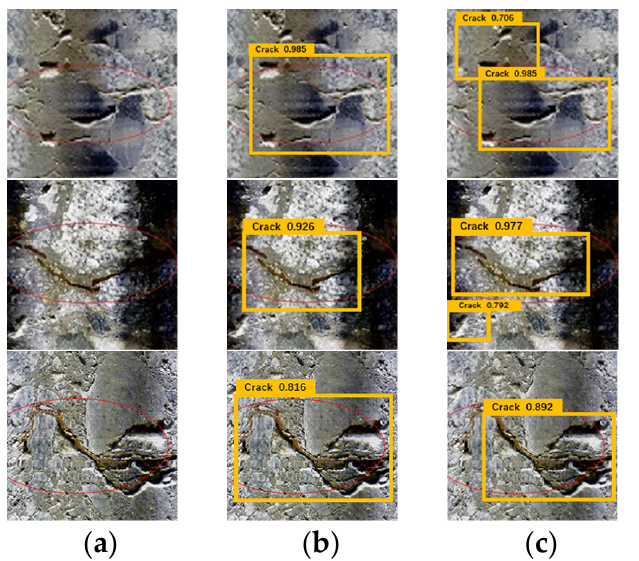
Figure 15. Detection effect comparison diagram. ( a ) Original image of cracks. ( b ) Test results before improvement. ( c ) Test results after improvement. improvement. ( c ) Test results after